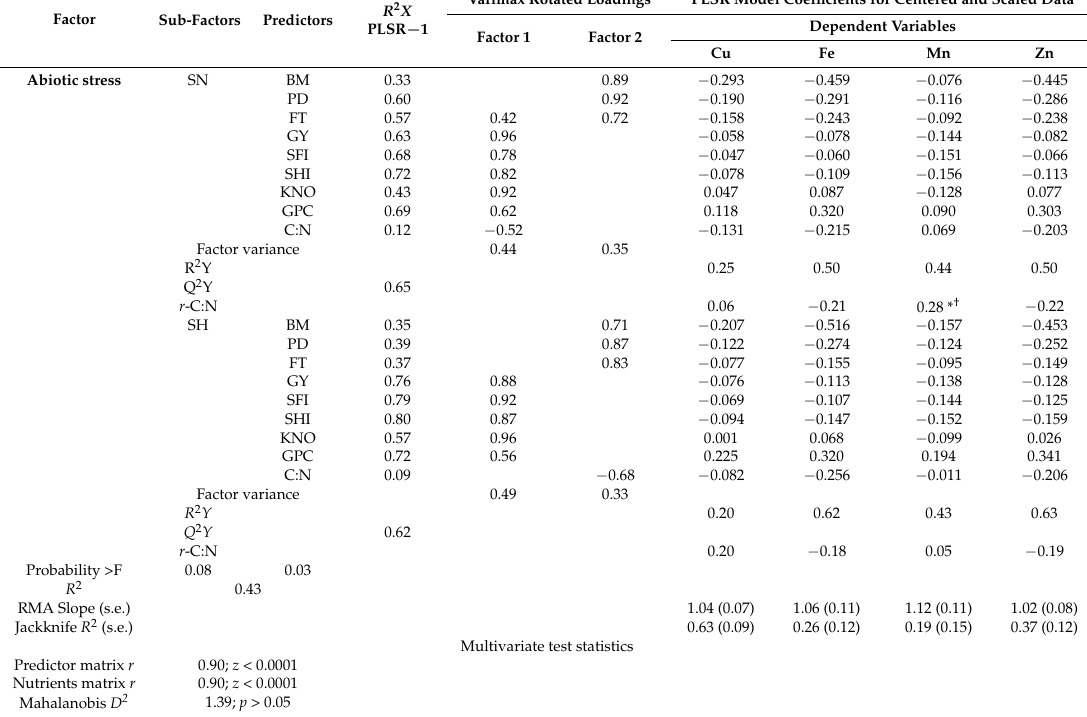
Table 7. Multiple comparisons between two abiotic stress levels (SN: short growing season and normal population density, and SH: short growing season and high population density) of T. aestivum and T. durum , using partial least squares regression (PLSR), factor analyses, prediction of micronutrients as functions of phenotypic plasticities, multivariate distances, and matrix correlations between predictors and between predicted